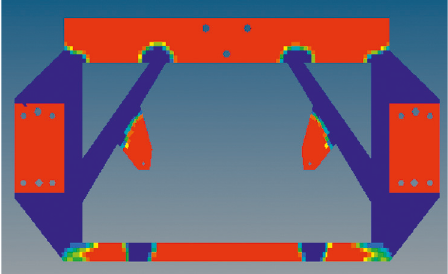
Figure 9: Optimization iteration results based on the average frequency method.